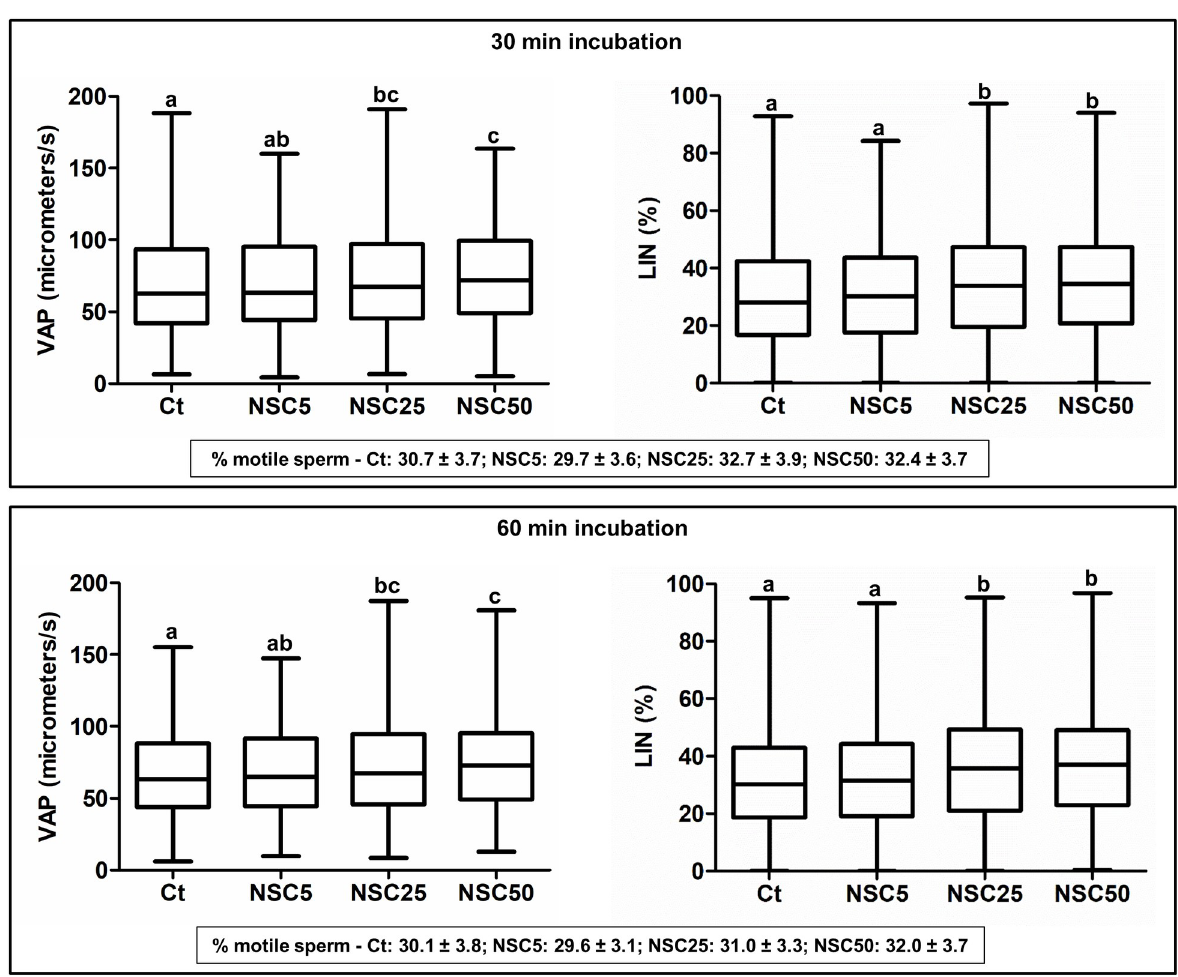
Fig 6. Effects of RAC1 inhibition on motility parameters of bull sperm. Box plots (showing the median and first and third quartiles) with whiskers (from minimum to maximum) of average path velocity (VAP) and linearity (LIN) of sperm incubated without (Ct: control) or with different concentrations of NSC23766 (NSC, μ M) for 30 min (n = 2186, 2224, 2116 or 2493 sperm for Ct, NSC5, NSC25 or NSC50, respectively) and 60 min (n = 2128, 2092, 2156 or 2572 sperm for Ct, NSC5, NSC25 or NSC50, respectively). For each condition, the percentage of motile sperm (mean ± standard error, n = 7 samples) is also shown (bottom boxes). Statistically significant differences between treatments are indicated by distinct letters ( Ps < 0.001).